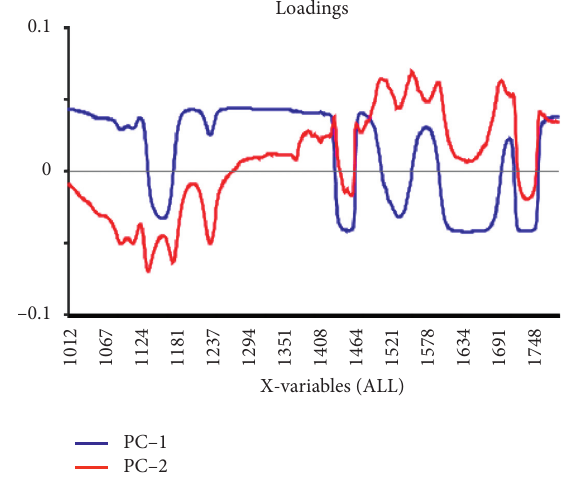
Figure 4: Loading plots for the first two PCs corresponding to the PCA in Figure